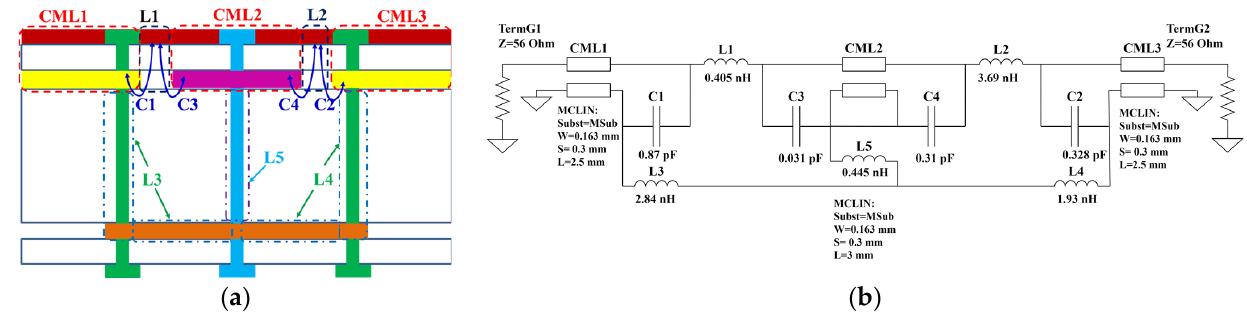
Figure 5. ( a ) The MDCRP structure filter side view. ( b ) Equivalent half-circuit model.